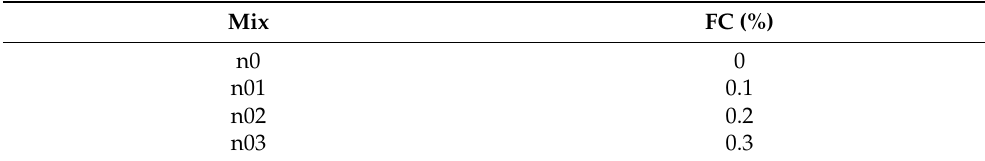
Table 1. Sample codes of the lime pastes prepared with a water to binder ratio of 0.81 and relative weight content of fibrillated cellulose (FC) per weight of